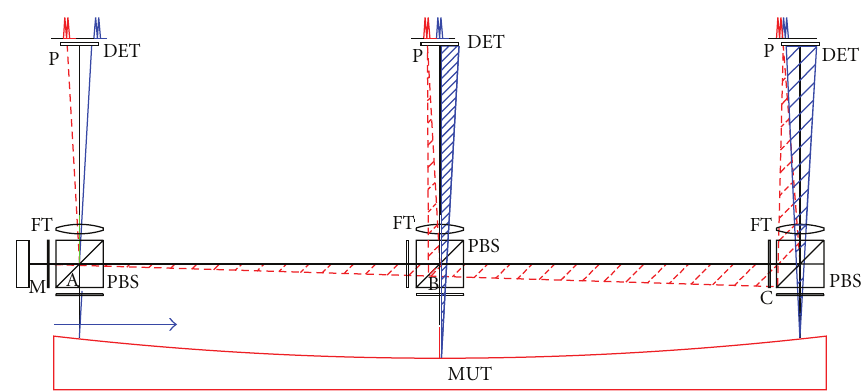
Figure 1: Sample and reference beams’ lateral motion in scan optical head